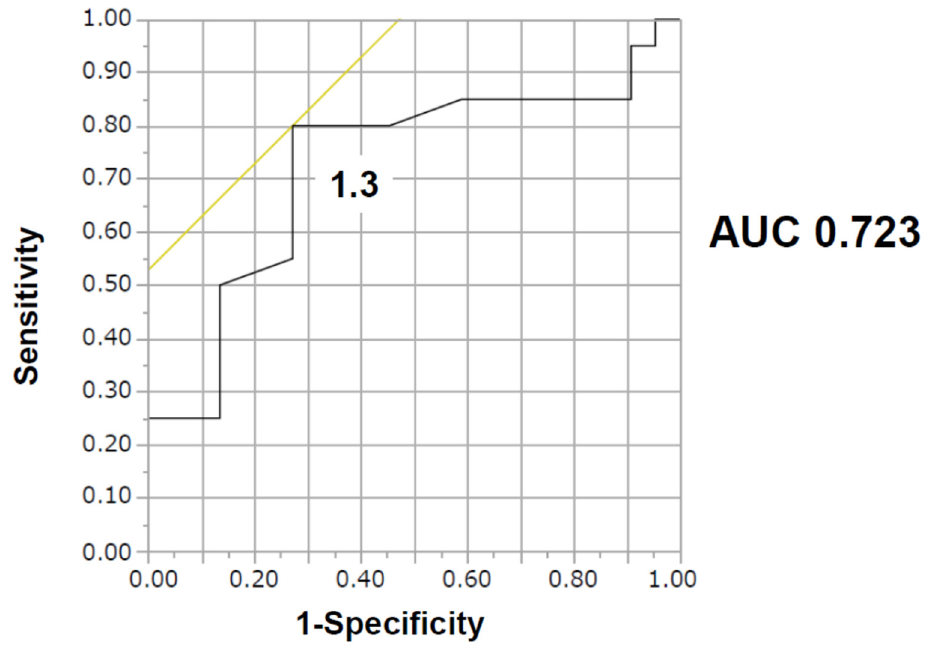
Figure 1. The cut-off pulmonary artery pulsatility index for hemolysis was calculated as 1.3 with an area under the curve of 0.7361, by receiver operating characteristic analyses. AUC, area under the curve.